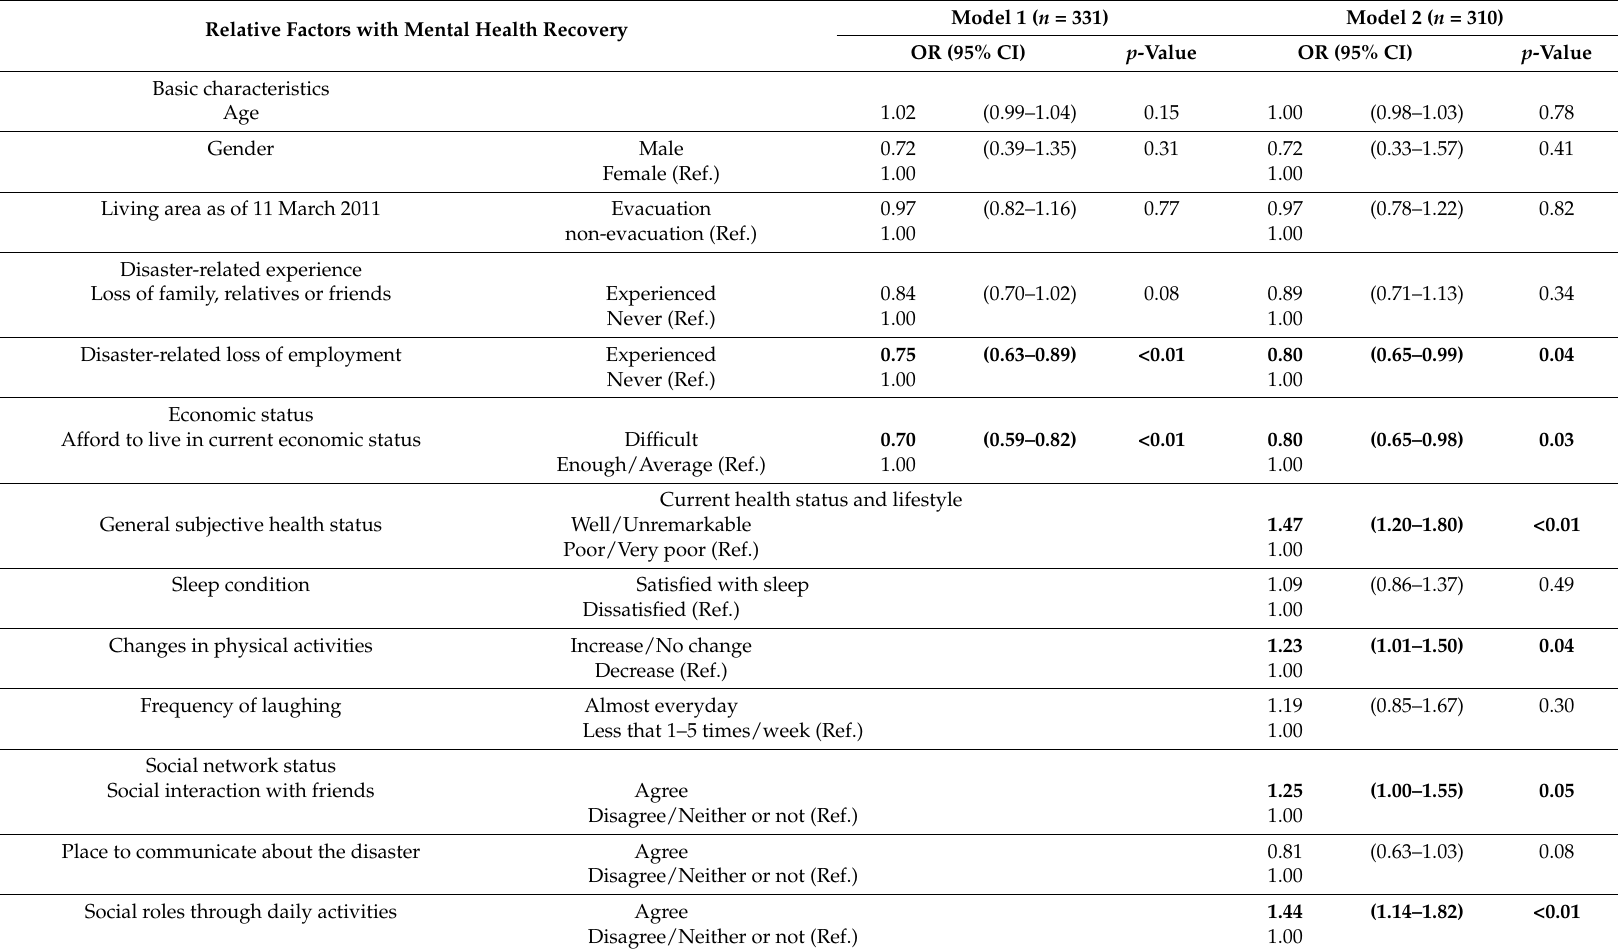
Table 5. Multivariable logistic regression analysis between mental health recovery and related